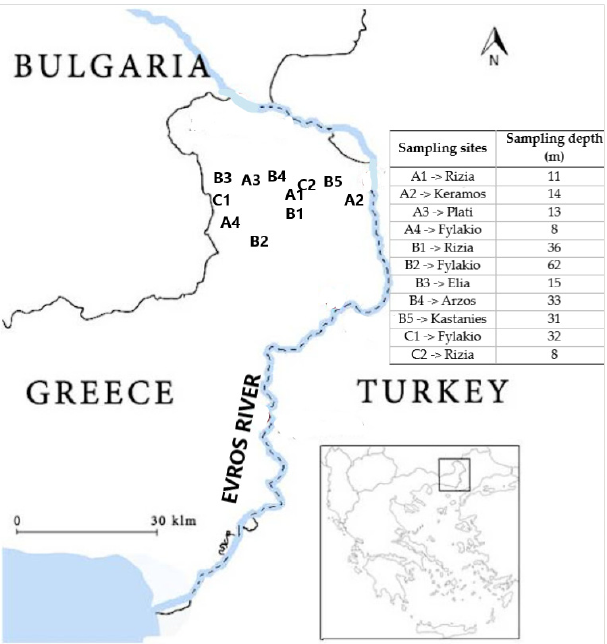
Figure 1. Study area of a transboundary aquifer (among Greece, Turkey and Bulgaria) and sampling sites. The capital letters A, B and C represent the experimental boreholes, drinking water wells and irrigation wells, respectively. Numbering identifies the villages close to sampling sites.